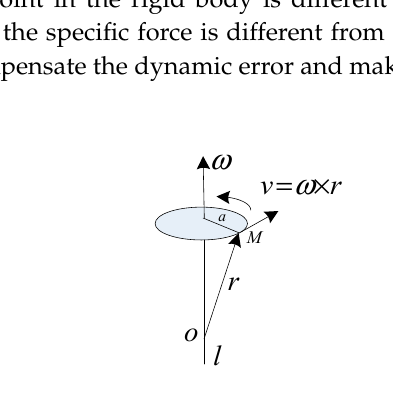
Figure 2. Diagram of dynamic error caused by the size effect.